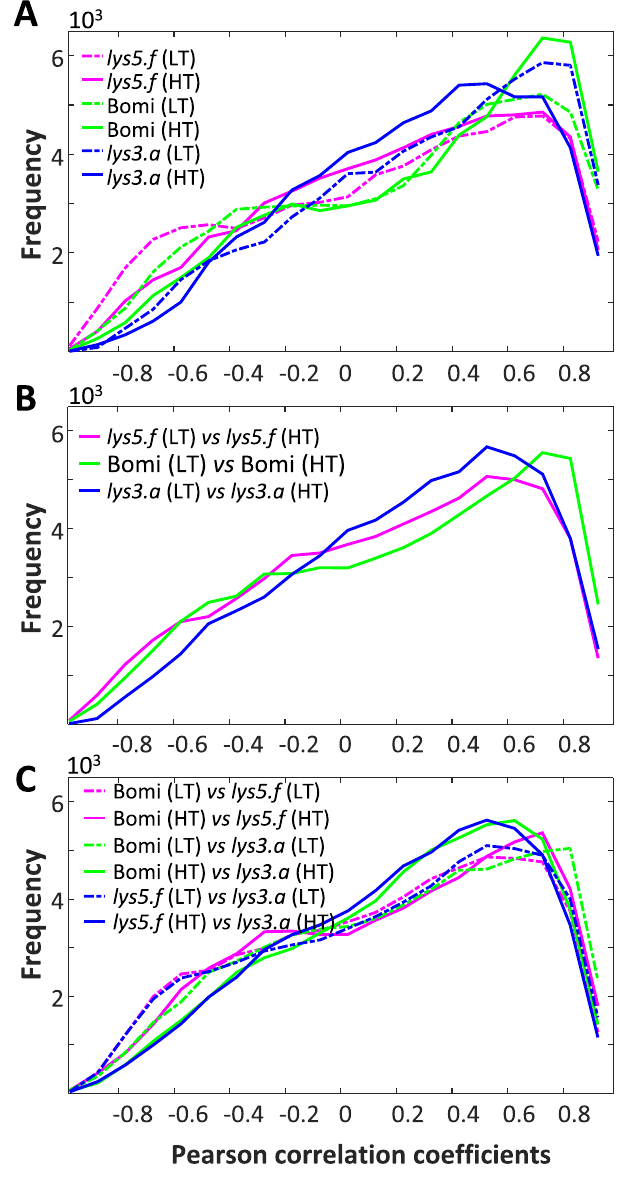
Figure 5. Distribution of Pearson correlation coefficients among metabolites during grain filling. ( A ) Distribution based on the correlation coefficients among metabolites within each genotype (GT) grown at two different temperatures. ( B ) Distribution based on the correlation coefficients among metabolites between the same genotype, but grown under different temperatures. ( C ) Distribution based on the correlation coefficients among metabolites between different genotypes, but grown under the same temperature. Although the X GT × X TEMP interaction effect was not significant (Fig. 1), a higher number of positive correlations was observed between Bomi and lys3.a at LT than between Bomi and lys5.f . This is in agreement with ANOVA- simultaneous component analysis (ASCA) of the GT effect, which showed a greater difference between Bomi and lys5.f than between Bomi and lys3.a . However, at the high temperature (HT) growth condition these correlations were no longer preserved, but the number of positive correlations was slightly increased between Bomi and lys5.f . Heatmaps of the corresponding correlation coefficient matrices and the number of significantly positive and negative correlations in those correlation coefficient matrices are illustrated in Supplementary Figs.